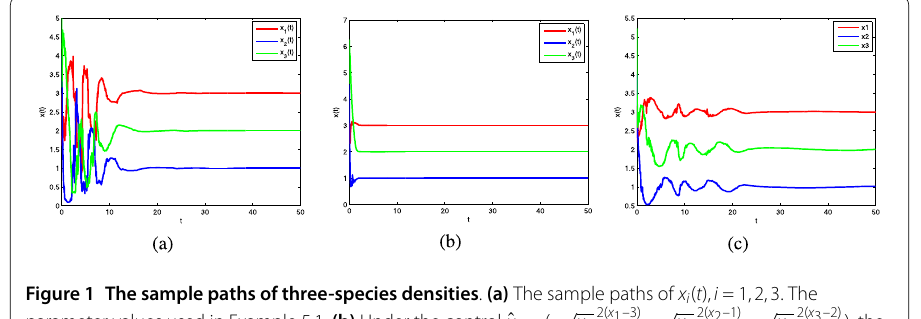
√ √ √ x 2 2( x 1–3) ,– x 3 2( x 2–1) ,– x 1 2( x 3–2) ), the x 1 x 2 x 3